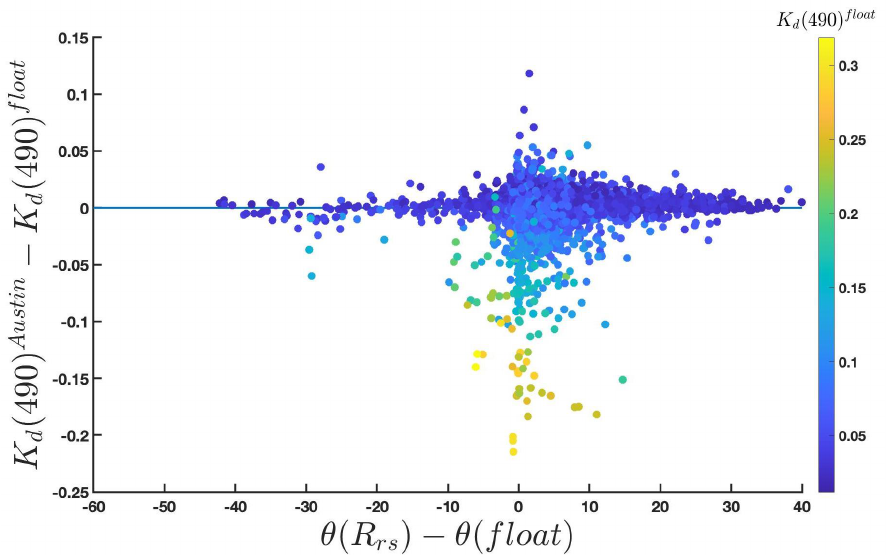
Figure A2. Residuals between for the operational algorithm ( K d ( 490 ) NASA / ESA ) and K d ( 490 ) float as a function of the difference between the solar zenith angle at the time of the sensor overpass ( θ ( R rs ) ) and the solar zenith angle when the BGC-Argo float surfaced ( θ ( float ) ). Scatter points are colored by the value of K d ( 490 ) NASA / ESA